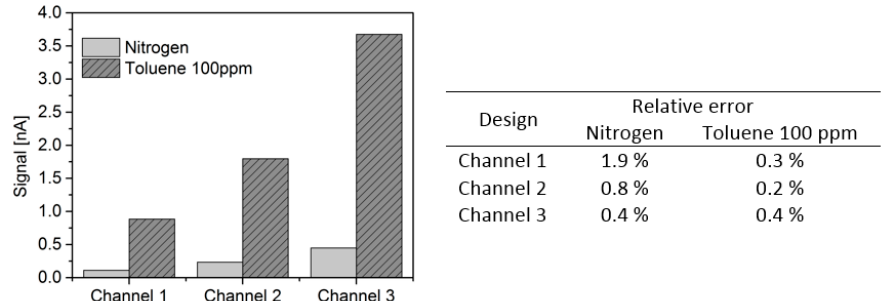
Figure 9. Signal for Channels 1, 2 and 3 using nitrogen and toluene 100 ppm as gas samples. Flow rate 20 mL/min and 30 V on electrodes. Relative uncertainty for signals of Channel 1 with nitrogen and toluene 100 ppm are 1.9% and 0.3%. Relative uncertainty for signals of Channel 2 with nitrogen and toluene 100 ppm are 0.8% and 0.2% respectively. Relative uncertainty for signals of Channel 3 with nitrogen and toluene 100 ppm are both 0.4%.